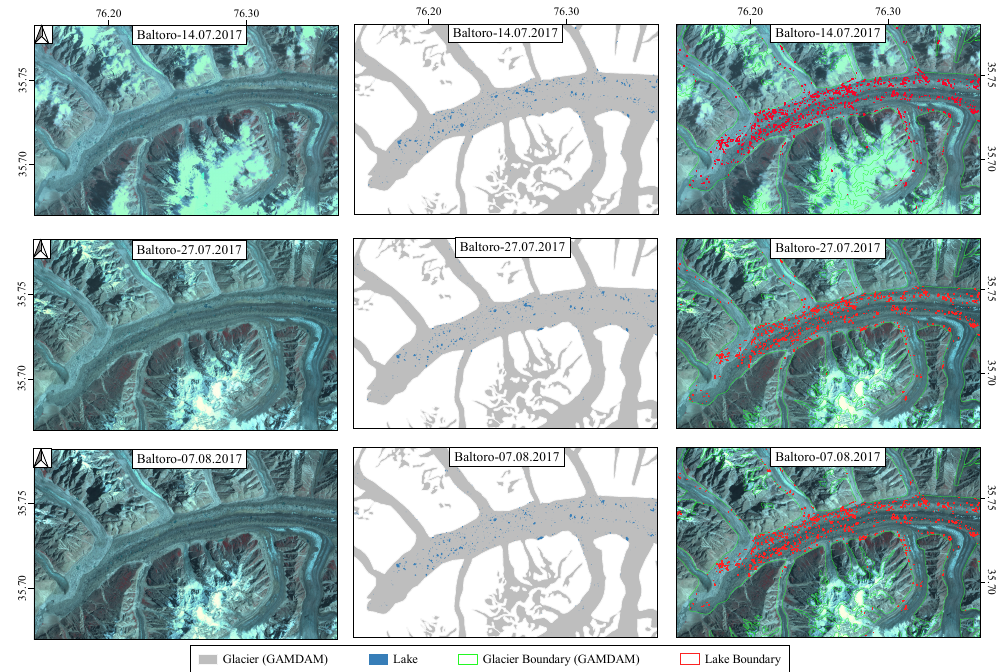
Figure 9. Intra seasonal variations in the supraglacial lakes on the Baltoro glacier. These images were acquired with approx. two weeks time difference. Mapped glacial lakes using the U-Net model are shown in the middle. Lake boundaries are displayed on the False Color Composite PlanetScope imagery.